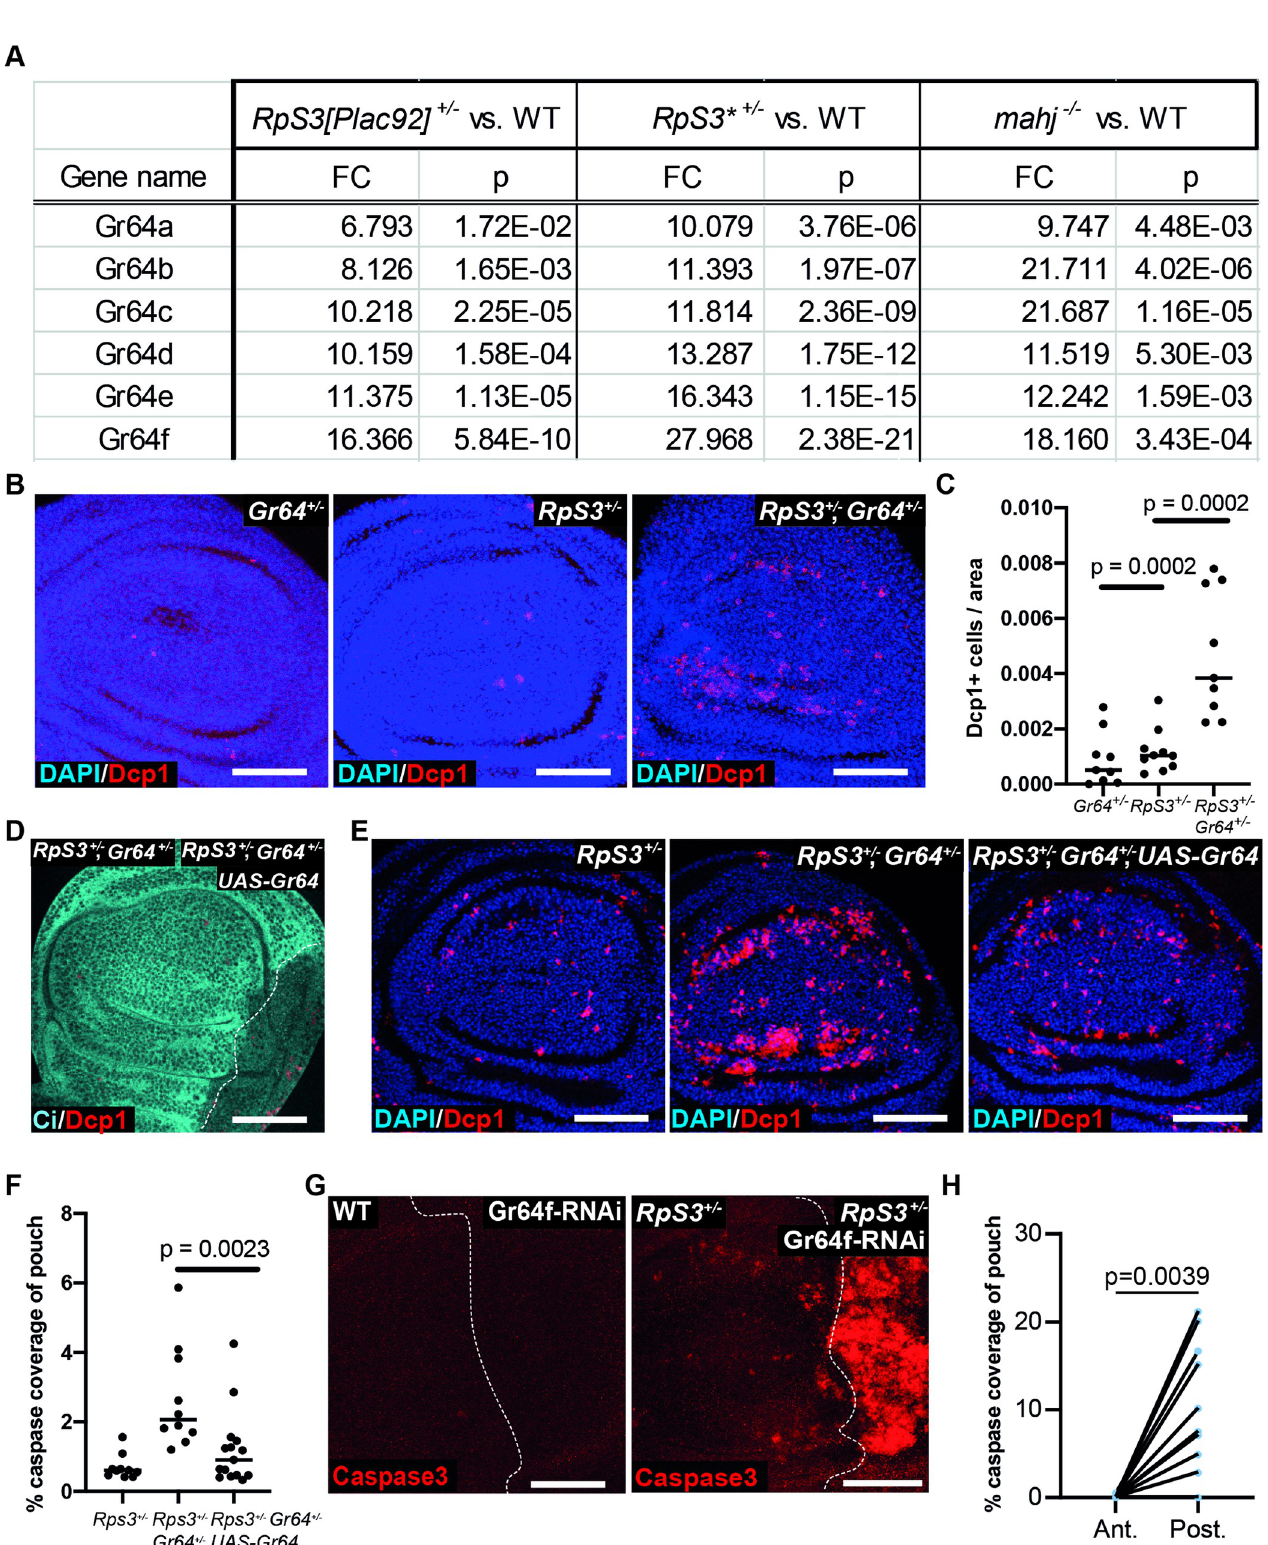
Fig 1. Noncompeting RpS3 +/- cells depend on Gr64 for their survival. ( A ) Fold change differences in Gr64 transcript expression relative to WT in wing discs heterozygous mutant for RpS3 (as detected in 2 separate mutant alleles: RpS3{Plac92} or RpS3 � ) or homozygous mutant for mahjong (mahj) . Numbers and p-